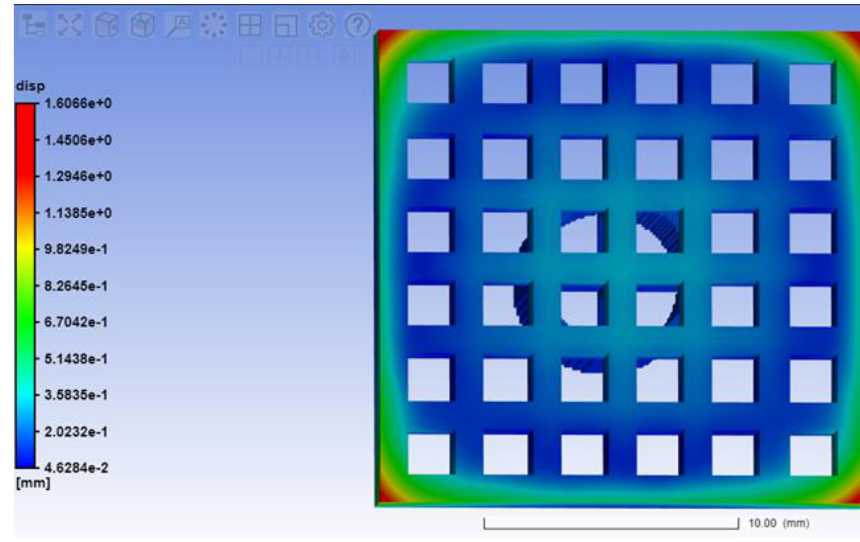
Figure 6. Deformation of the ET after separation from the